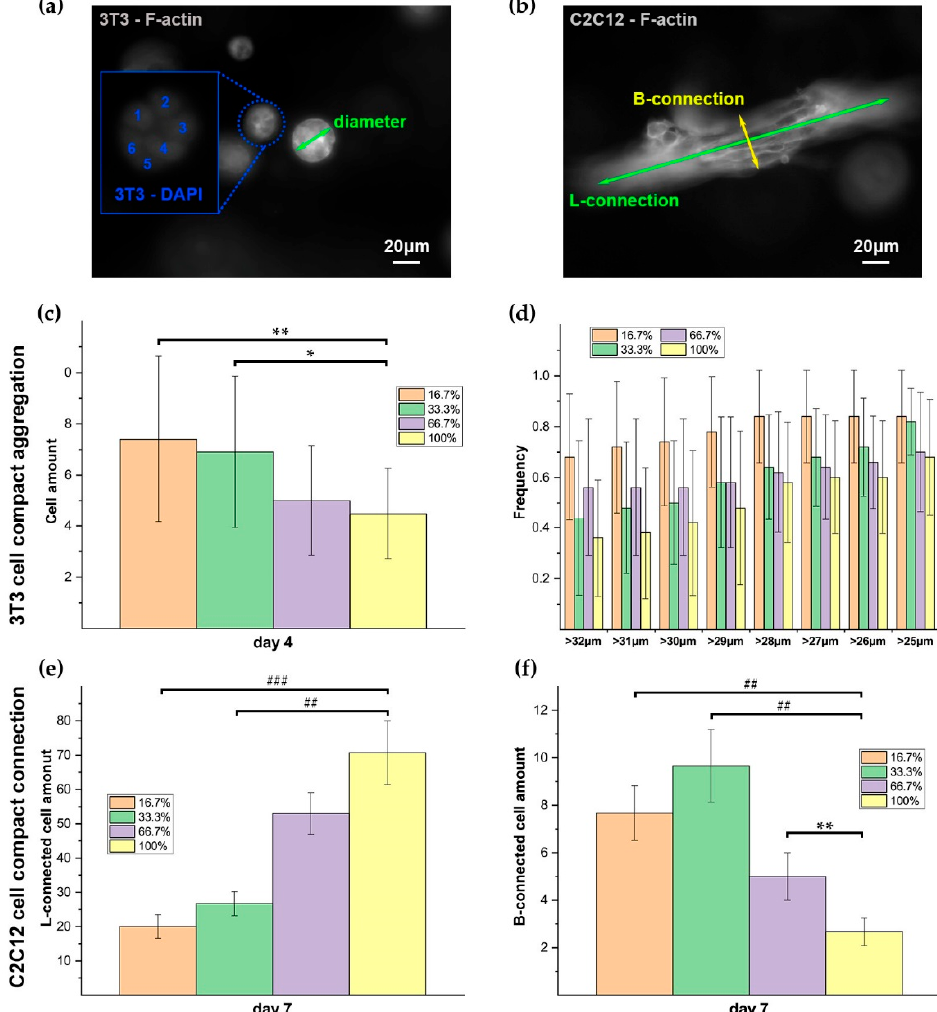
Figure 11. The impact of the composition configuration of 3D dextran hydrogels with clustered and homogenous RGD distribution on cellular collective behaviors. The main parameters of dextran hydrogel were crosslinking strength = 2 mM and RGD = 50 µM. ( a ) The measuring scheme for cell amount of aggregated 3T3 cells and diameter of big 3T3 cell clumps; ( b ) The measuring scheme for cell amounts of L-connected and B-connected C2C12 cells; ( c ) Cell amount of aggregated 3T3 cells on day 4 in groups 1–4; ( d ) Frequency of 3T3 cells growing into big clumps on day 7 in groups 1–4; ( e ) Cell amount of L-connected C2C12 cells on day 7 in groups 1–4; ( f ) Cell amount of B-connected C2C12 cells on day 7 in groups 1– 4. The measurements were conducted by ImageJ software. The data were presented by mean ± SD; * p < 0.05, ** p < 0.03, ## p < 0.003, and ### p < 0.001 versus the corresponding 3D homogenous samples.